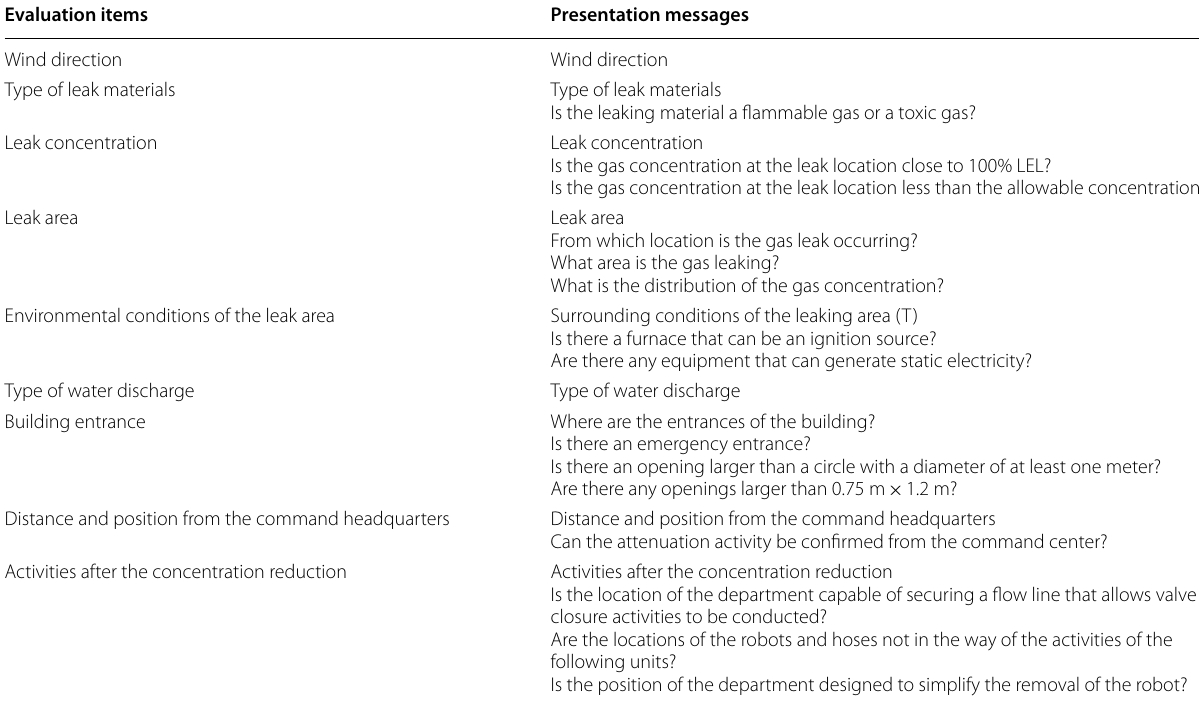
Table 9 Presentation messages during the attenuation activity